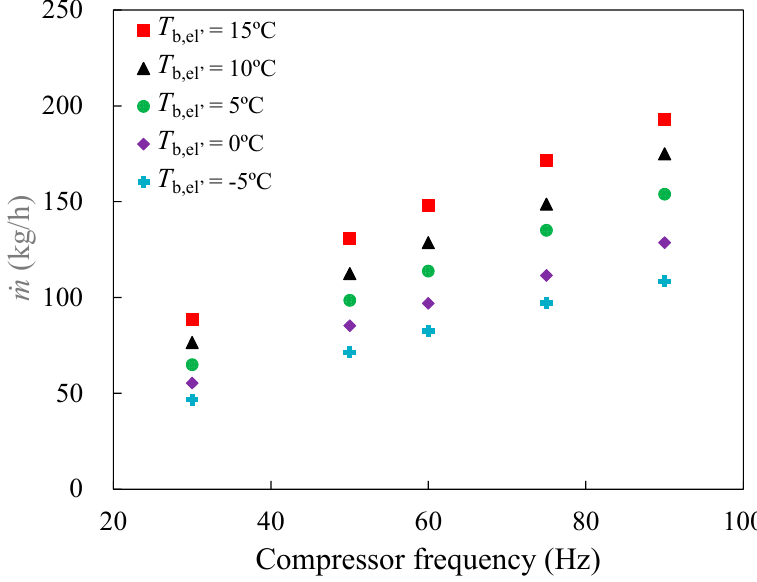
. m as a function of compressor